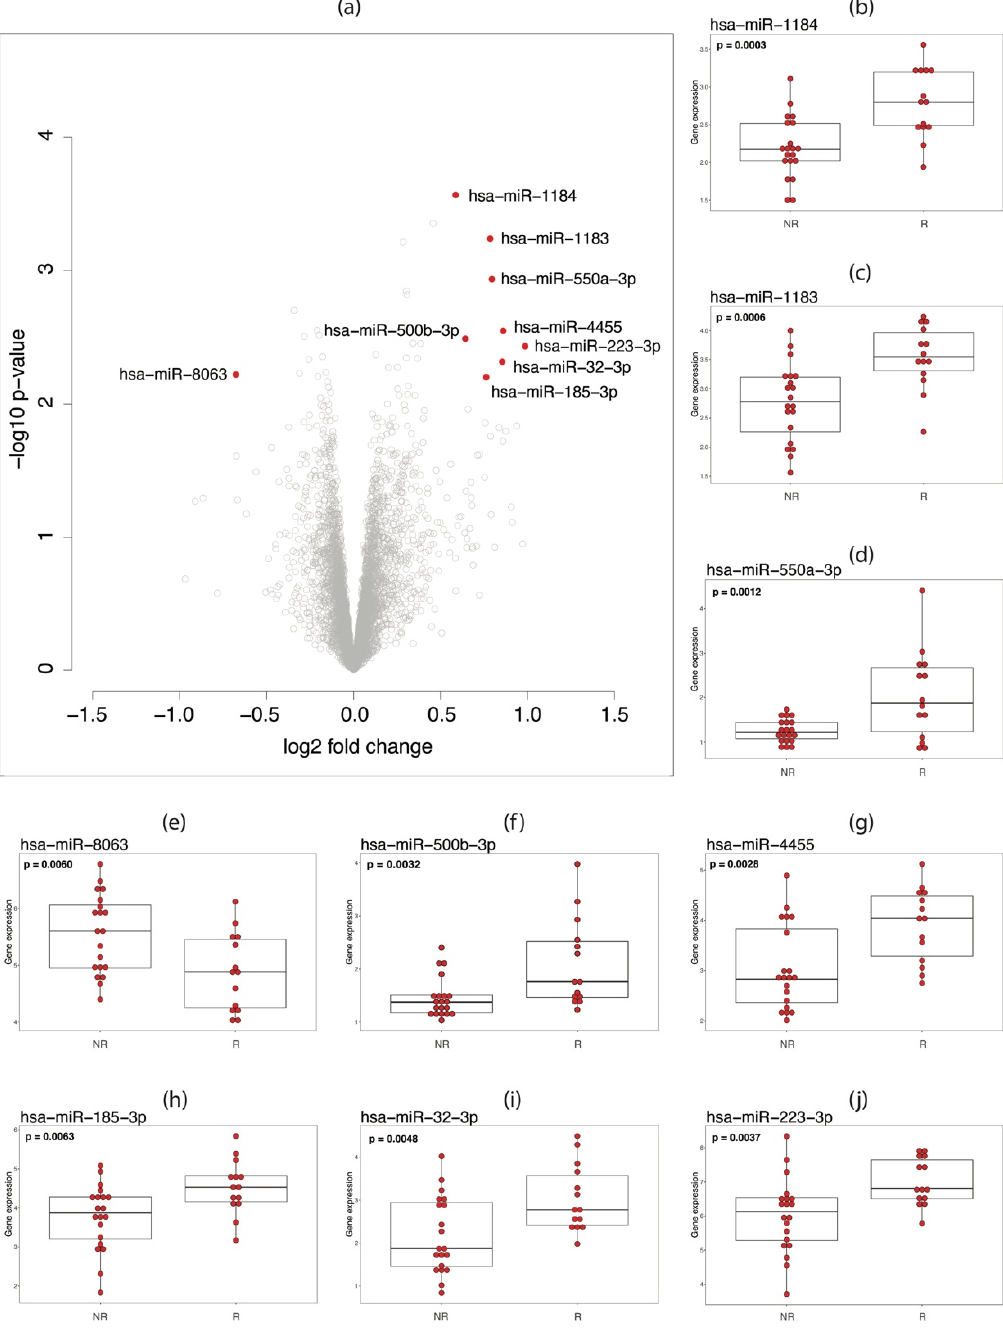
Figure 3. Differential expression analysis of miRNA between responders and non-responders in the DCV2 trial. ( a ) Volcano plot of the comparison of miRNA expression between responders and non-responders. Significant differential expression was defined by an unadjusted p -value < 0.05 and a log absolute fold change > 0.5. The nine miRNAs fulfilling these conditions are labeled and marked in red. ( b – j ) Expression of the 9 most significantly differentially expressed miRNAs marked in panel a . Box plots and individual gene expression values (red dots) are plotted for non-responders (NR) and responders (R) in each case. Unadjusted p -values are given in each plot.